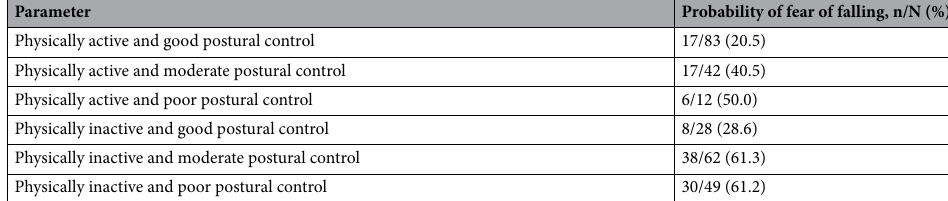
Table 3. Probability of fear of falling related to the presence or absence of risk factors (N = 279). Physically active: SGPALS score 2–3; physically inactive: SGPALS score 1; good postural control: SwePASS score ≥